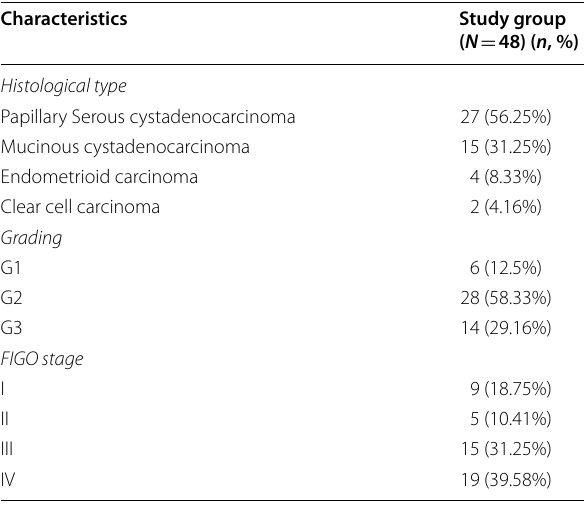
FIGO International Federation of Gynecology and Obstetrics